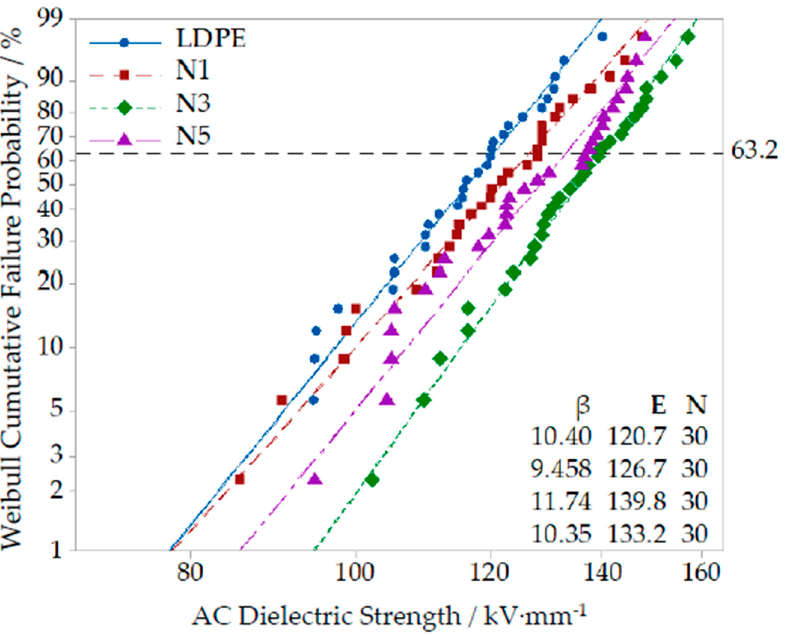
Figure 7. AC breakdown field strength Weibull diagram of Nano-composites and pure LDPE.